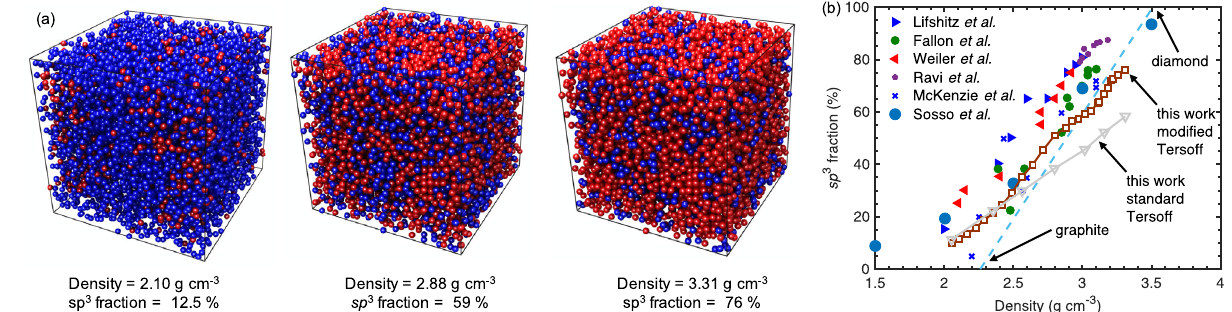
Fig. 1 Concentration of sp 3 -bonded carbon atoms in amorphous carbon at different mass densities. a Schematic of our amorphous carbon computational domains showing different ratios of sp 2 to sp 3 hybridized carbon atoms at three representative mass densities; the red atoms correspond to sp 3 -bonded carbon atoms with a four-fold coordination. b Percentage of sp 3 -bonded carbon atoms in the amorphous structures as a function of the mass density showing a linear increase with increasing density for structures described by both the standard and the modi fi ed Tersoff potentials. In comparison to the experimental measurements and results from density functional theory calculations, the modi fi ed Tersoff potential (with a larger cutoff distance of 2.45 Å ) is better able to predict the correct sp 3 -bonded carbon fraction in the amorphous structures, especially at higher densities 62 – 67